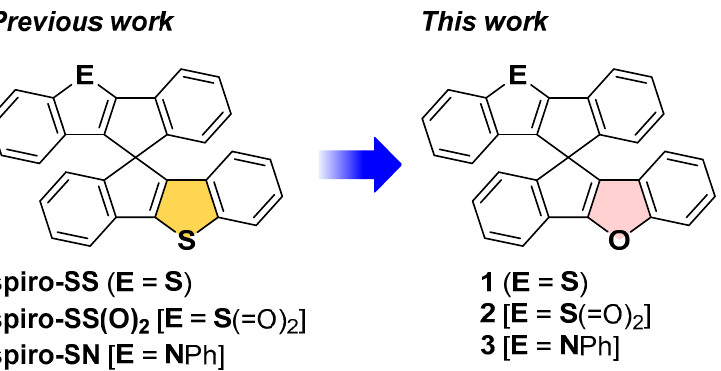
Figure 1. Molecular structures of previously reported chiral spiro-fused PACs and 1 – 3 in this study.